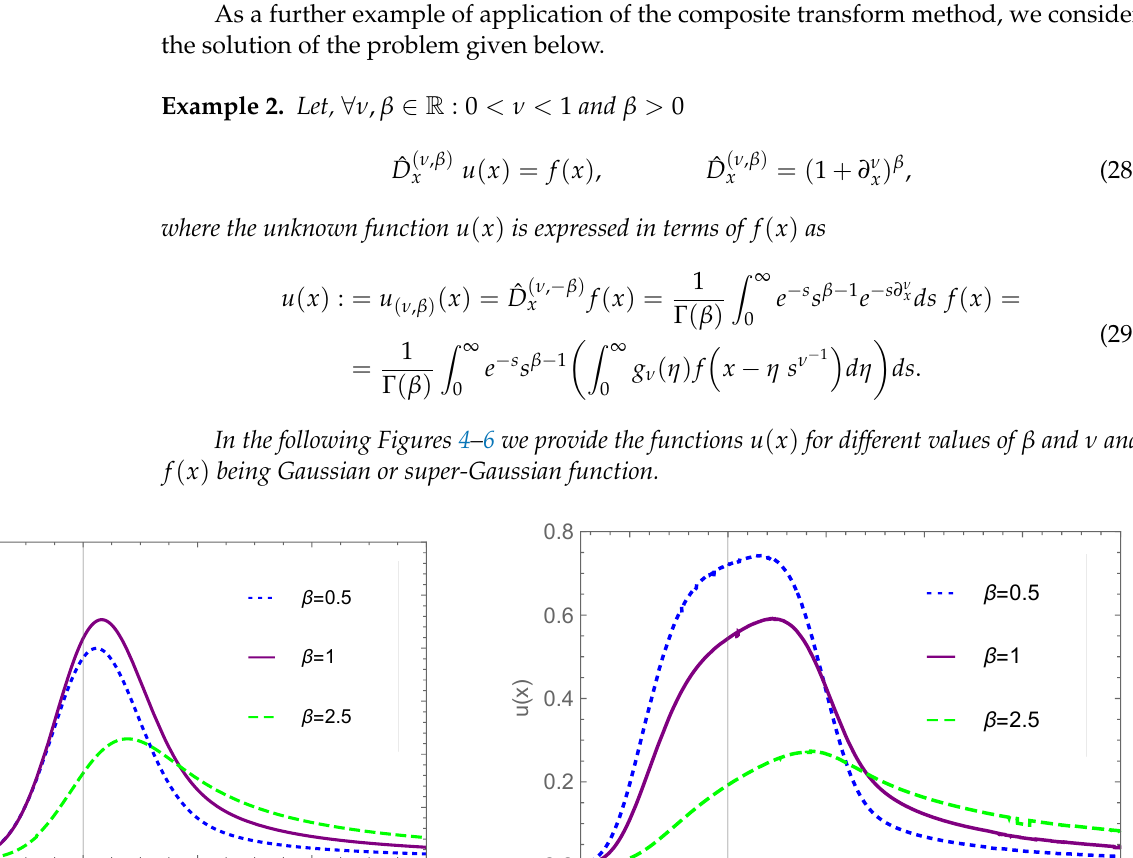
and f ( x ) Gaussian or super-Gaussian function. ( a ) f ( x ) = e − x 2 ; ( b ) 2